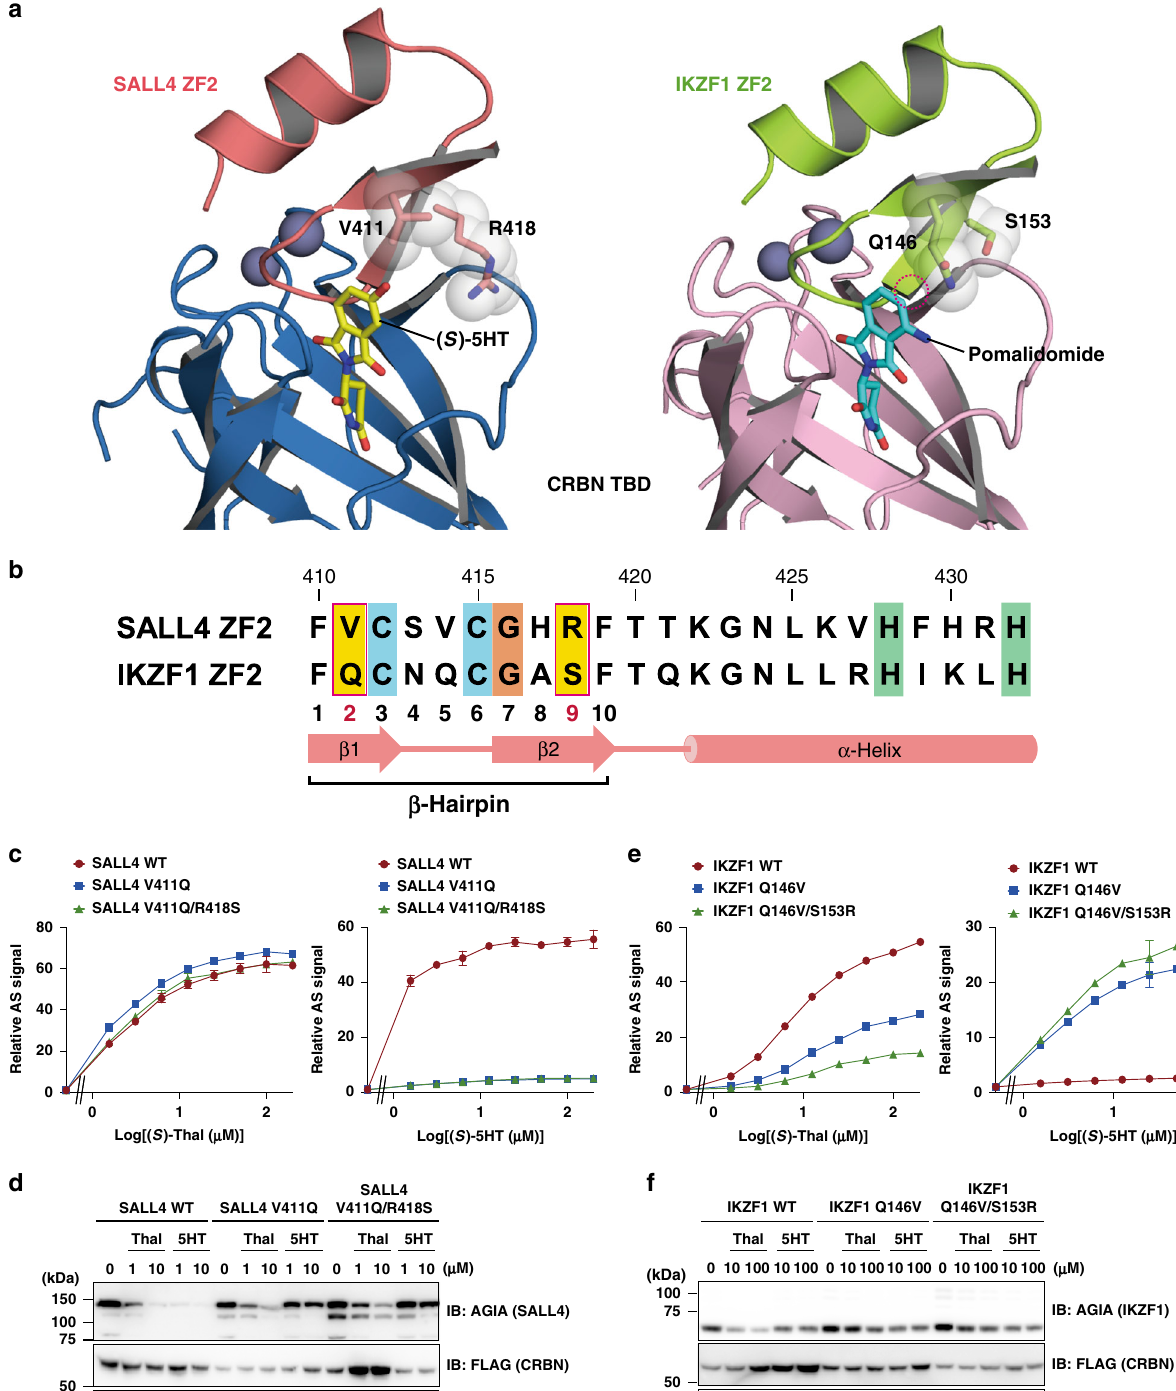
show whether what range and what tissues are damaged by thalidomide and 5HT through the molecular interactions pro- posed in this